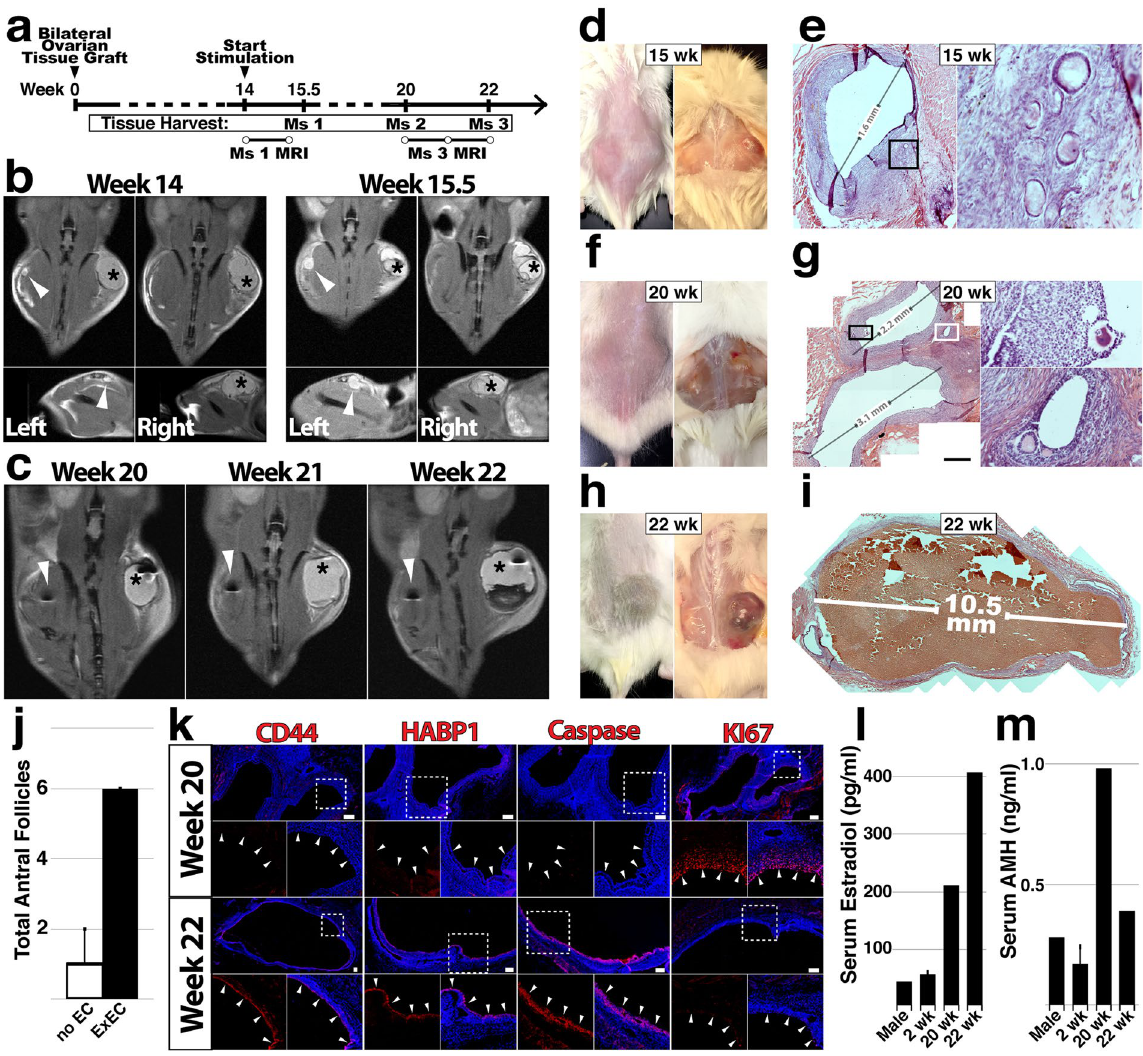
Figure 3. Long-term viability and function of ovarian tissue grafts are improved by ExECs. ( a ) Experimental scheme for long-term xenograft of ovarian cortical tissue. ( b ) Mouse #1 was xenografted with tissue from a 6-year-old donor and monitored by MRI at the onset of stimulation (14 weeks, left) and again after ten days of stimulation (right). ( c ) Mouse #3 was xenografted with tissue from a 19-year-old donor and monitored by MRI at 6 (20 weeks post-transplant), 7 (21 w) and 8 (22 w) weeks following the onset of stimulation. d and e) Mouse #1 was sacrificed after 15.5 weeks and control and ExEC-assisted grafts were harvested for histological analysis; in ( d ) the graft on the right side is the ExEC-assisted graft and a histological view of the control graft is shown in ( e ). ( f , g ) Mouse #2 was sacrificed after 20 weeks and control and ExEC-assisted grafts were harvested for histological analysis; the ExEC-assisted graft is shown in ( g ). ( h , i ) Mouse #3 was sacrificed after 22 weeks and control and ExEC-assisted grafts were harvested for histological analysis; the ExEC-assisted graft is shown in ( i ). ( j ) Median of total number of antral follicles in ExEC-assisted versus control grafts from Mice 1–3 + MAD. N = 3. k) Sections of the ExEC-assisted grafts from Mouse #2 and Mouse #3 were stained for molecular markers shown. ( l , m ) Serum isolated from control (male), short-term-2 weeks and long-term-20,22 weeks xenografted mice was tested by ELISA for levels of human Estradiol ( l ) and AMH ( m ). Insets in ( e , g , k ) are enlarged in the associated box. Scale bars = 100 μ